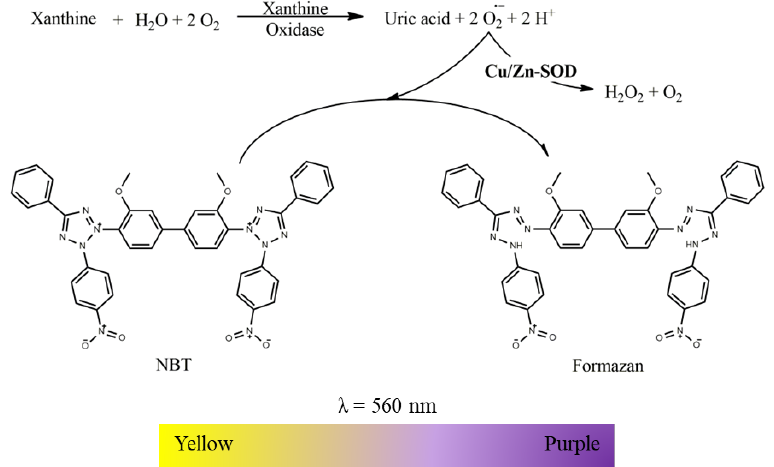
Figure 3. The xanthine/xanthine oxidase system generates O 2 •− disputed between Cu/Zn-SOD enzyme and the yellow NBT. Cu/Zn-SOD is responsible for the dismutation of O 2 •− into H 2 O 2 and molecular oxygen, and the NBT reacts with the O 2 •− producing the formazan, detectable at 560 nm.